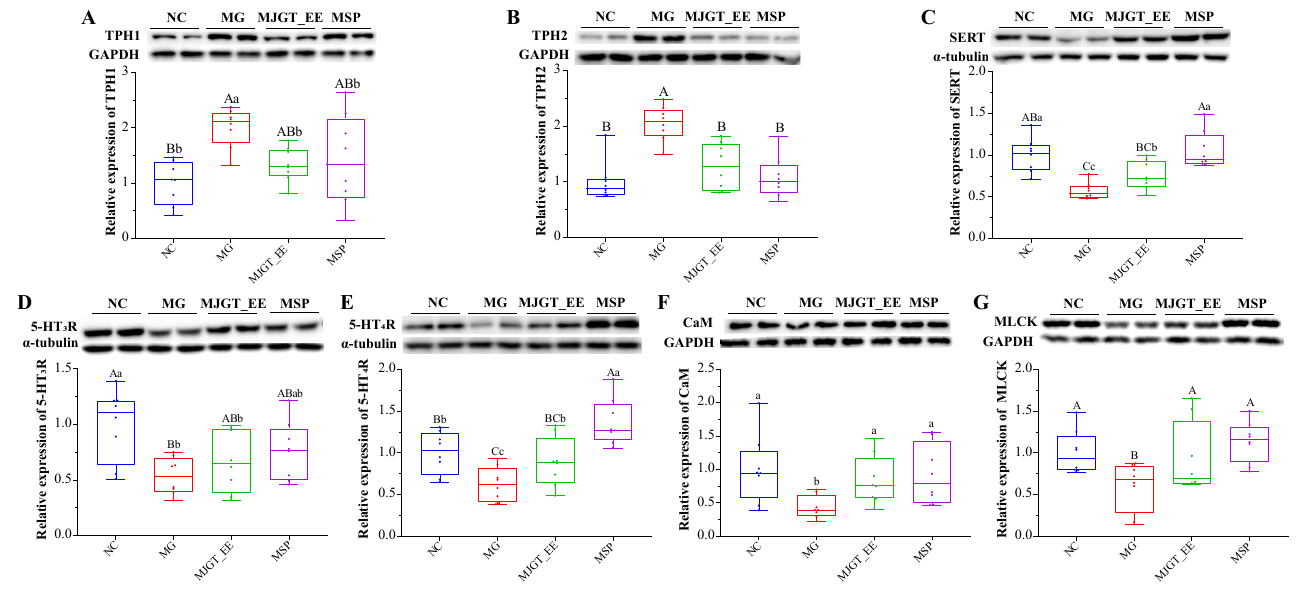
Figure 5. Western blotting analysis of TPH1 ( A ), TPH2 ( B ), SERT ( C ), 5-HT 3 receptors ( D ), 5-HT 4 receptors ( E ), CaM ( F ), and MLCK ( G ) in colonic tissues of each group. Capital and lowercase letters above the bar indicate the difference significance at the 0.01 or 0.05 levels, respectively. ( n = 8 for each group). NC: negative control group; MG: model group, MSP: mosapride group, MJGT_EE: Mao Jian Green Tea ethanol extract group; 5-HT: 5-hydroxytryptamine; TPH1: tryptophan hydroxylase 1; TPH2: tryptophan hydroxylase 2; SERT: serotonin transporter; CAM: calmodulin; MLCK: myosin light chain kinase; 5-HT 3 R: 5-HT 3 receptor; 5-HT 4 R: 5-HT 4